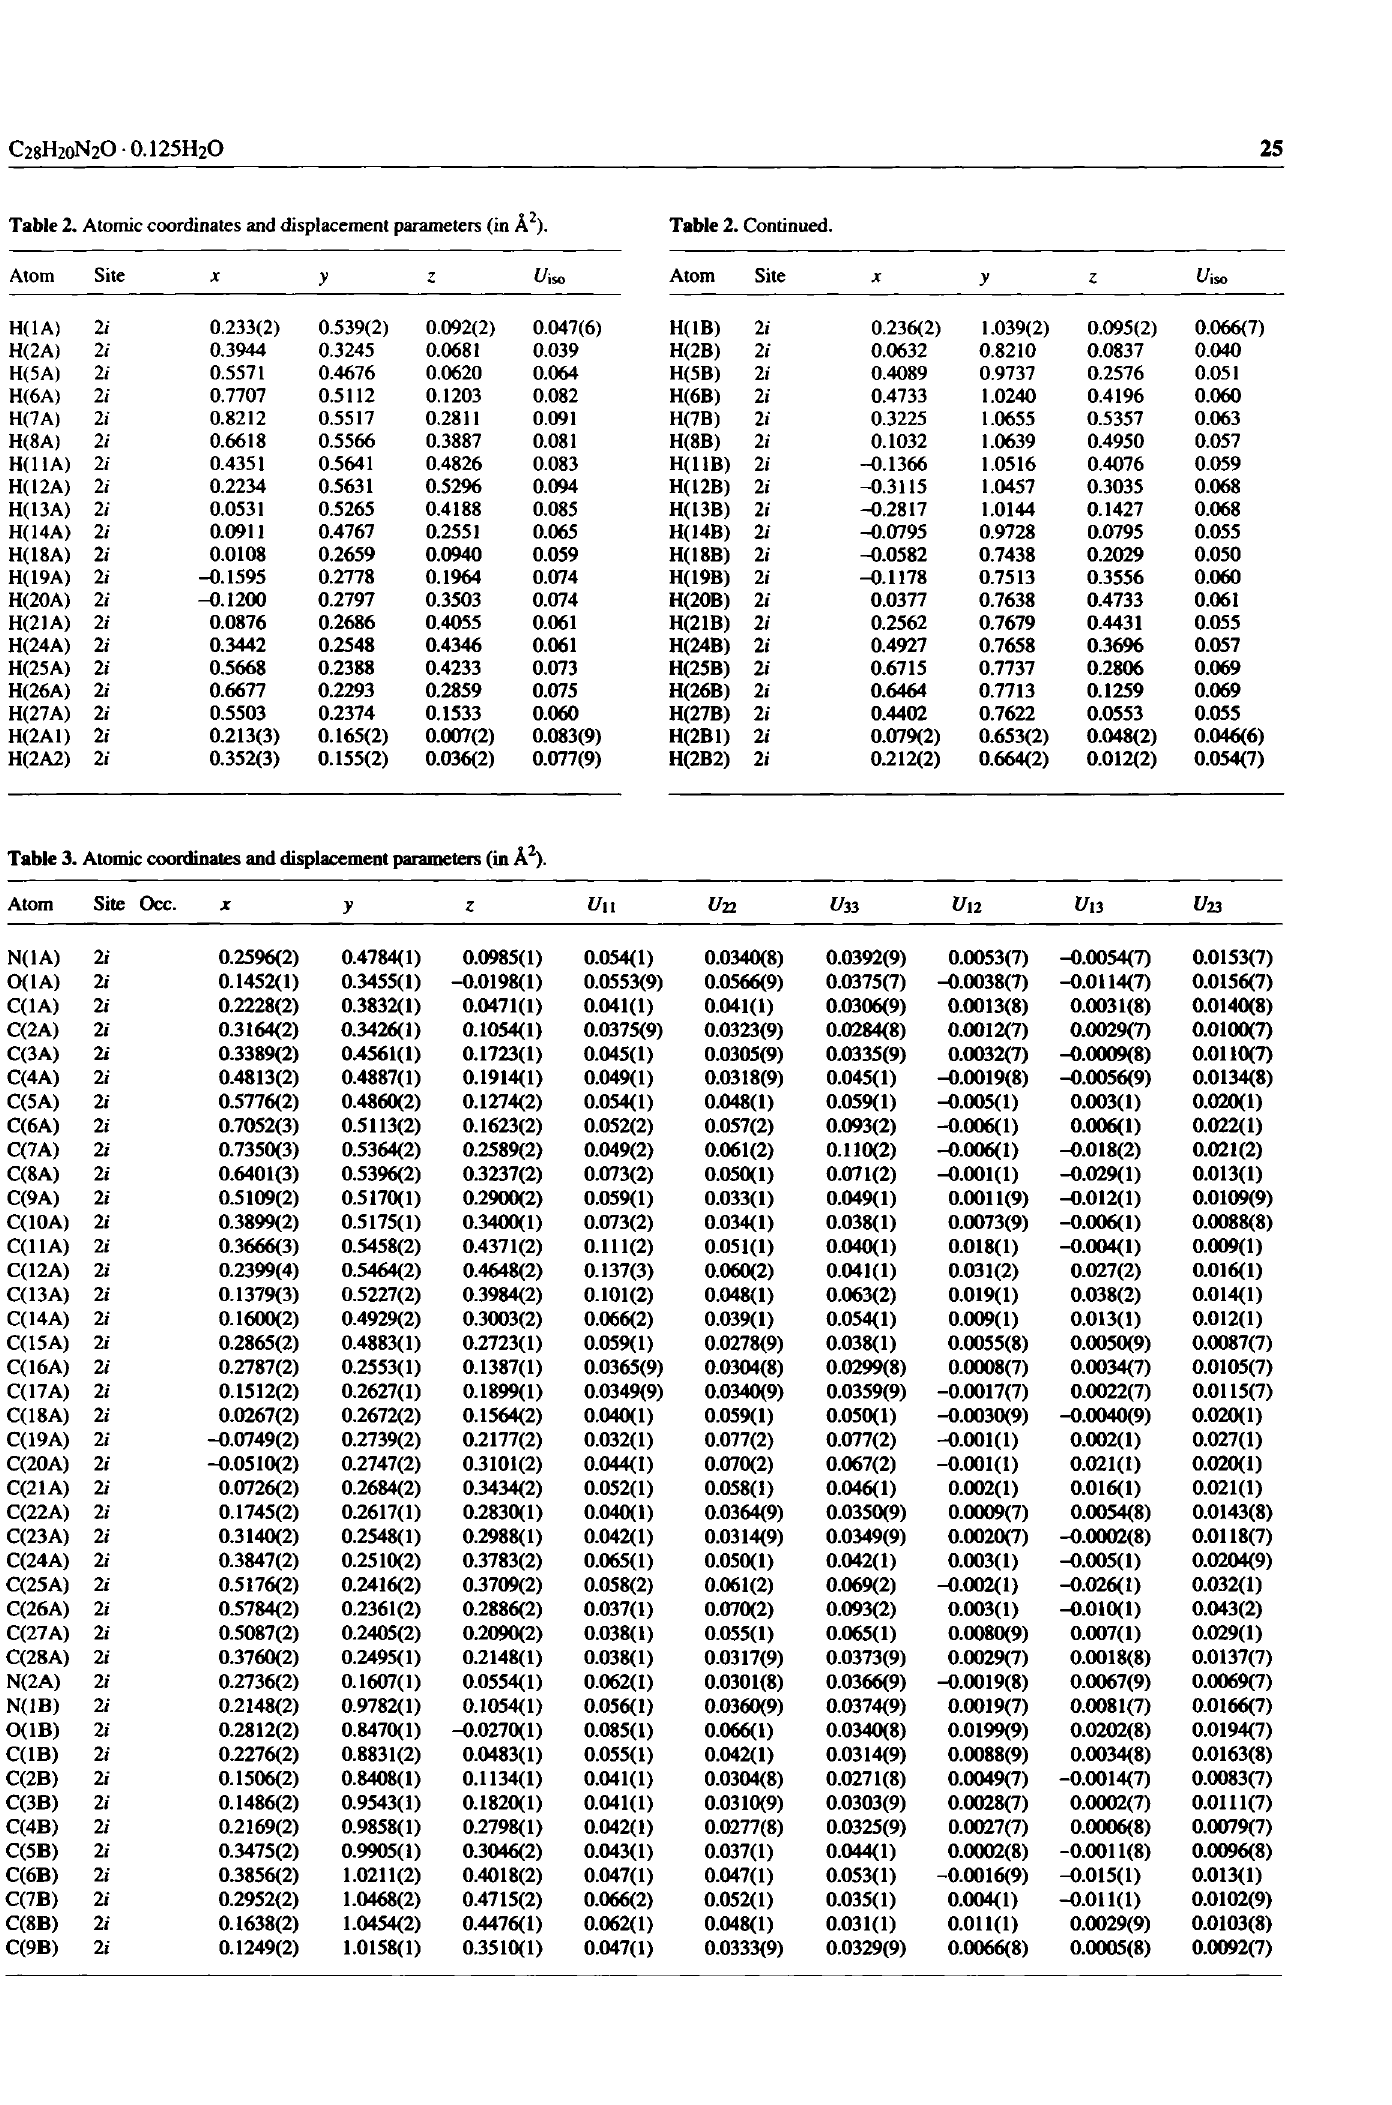
Table 3. Atomic coordinates and displacement parameters (in Â 2